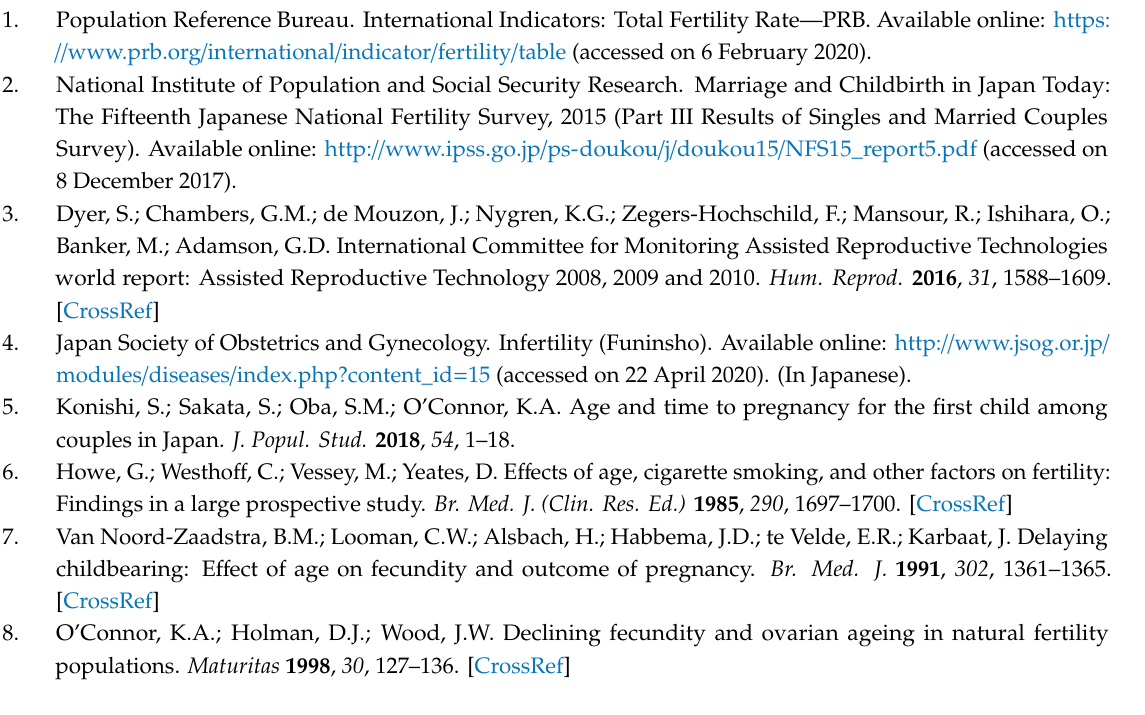
Figure S1: An example ( n = 1 woman with multiple cycles) of specific gravity (SG)-corrected daily concentrations of estrone-glucuronide (E1G) and pregnanediol-glucuronide (PDG) in urine with daily information on menstrual bleed, sexual intercourse, and ovulation (based on urinary LH) and pregnancy (based on urinary hCG) test results, Table S1: Di ff erence in days between day of luteal transition (DLT) and the first day of positive ovulation test in each cycle with DLT and at least 1 day with positive ovulation tests ( n = 52 cycles), Table S2: Number of menstrual cycles by number of days with positive LH test results and spontaneous conception during 24-weeks